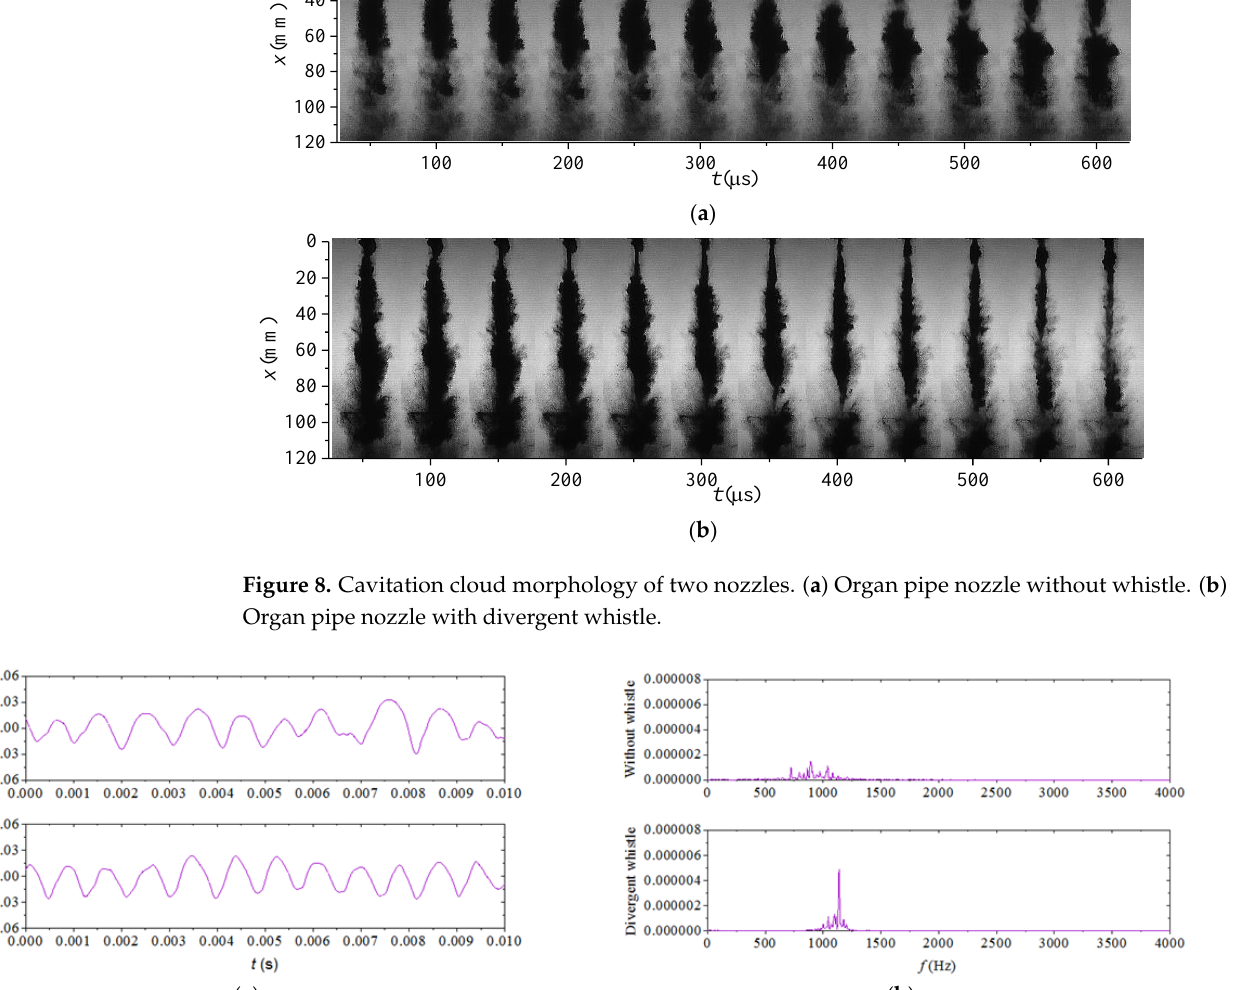
Figure 8. Cavitation cloud morphology of two nozzles. ( a ) Organ pipe nozzle without whistle. ( b ) Organ pipe nozzle with divergent whistle.